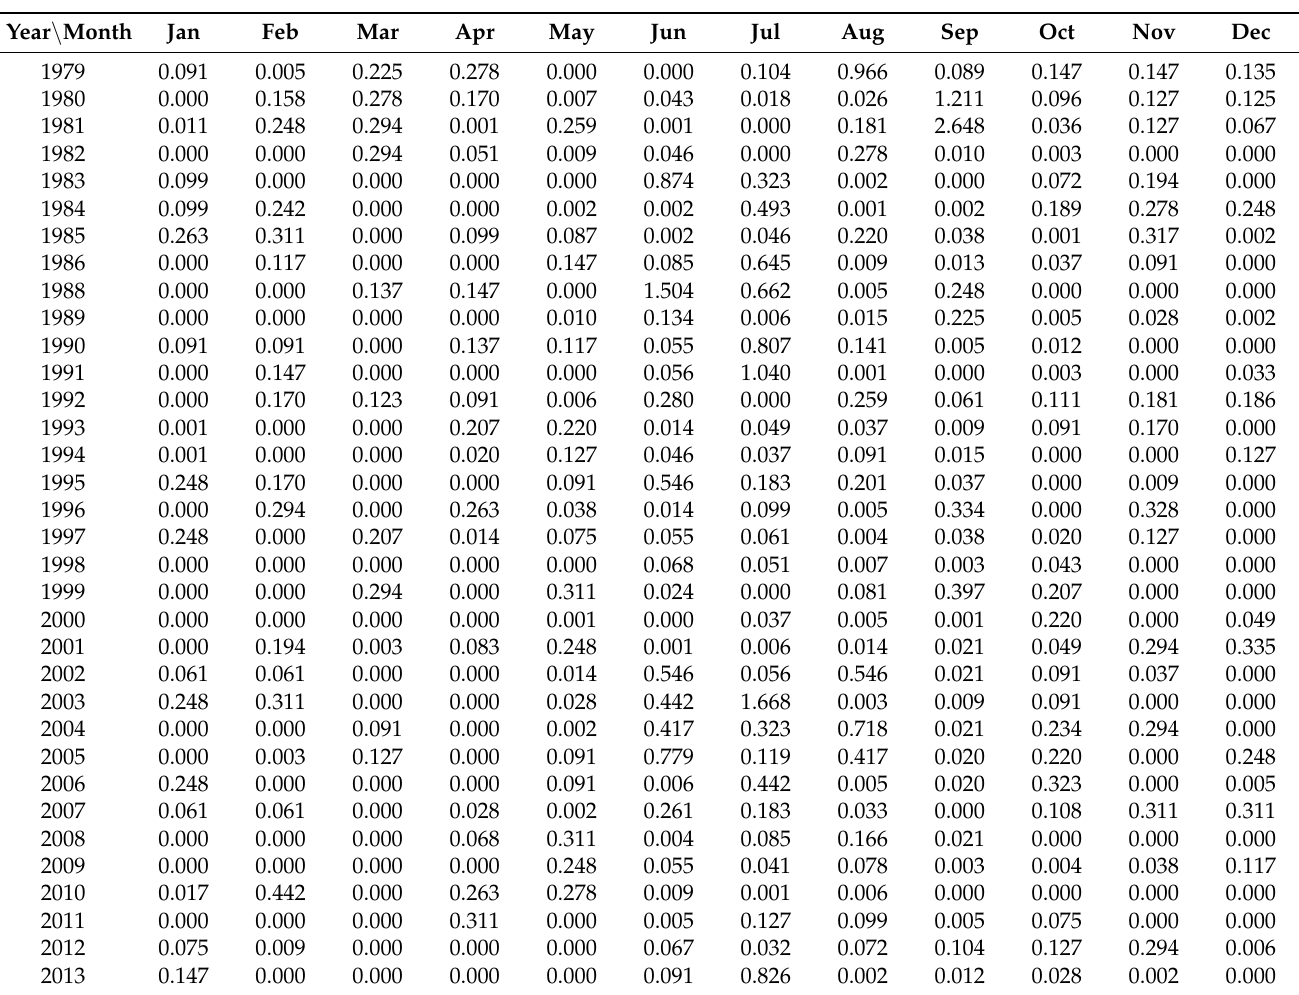
Table 2. Synthetic series of monthly flows (m 3